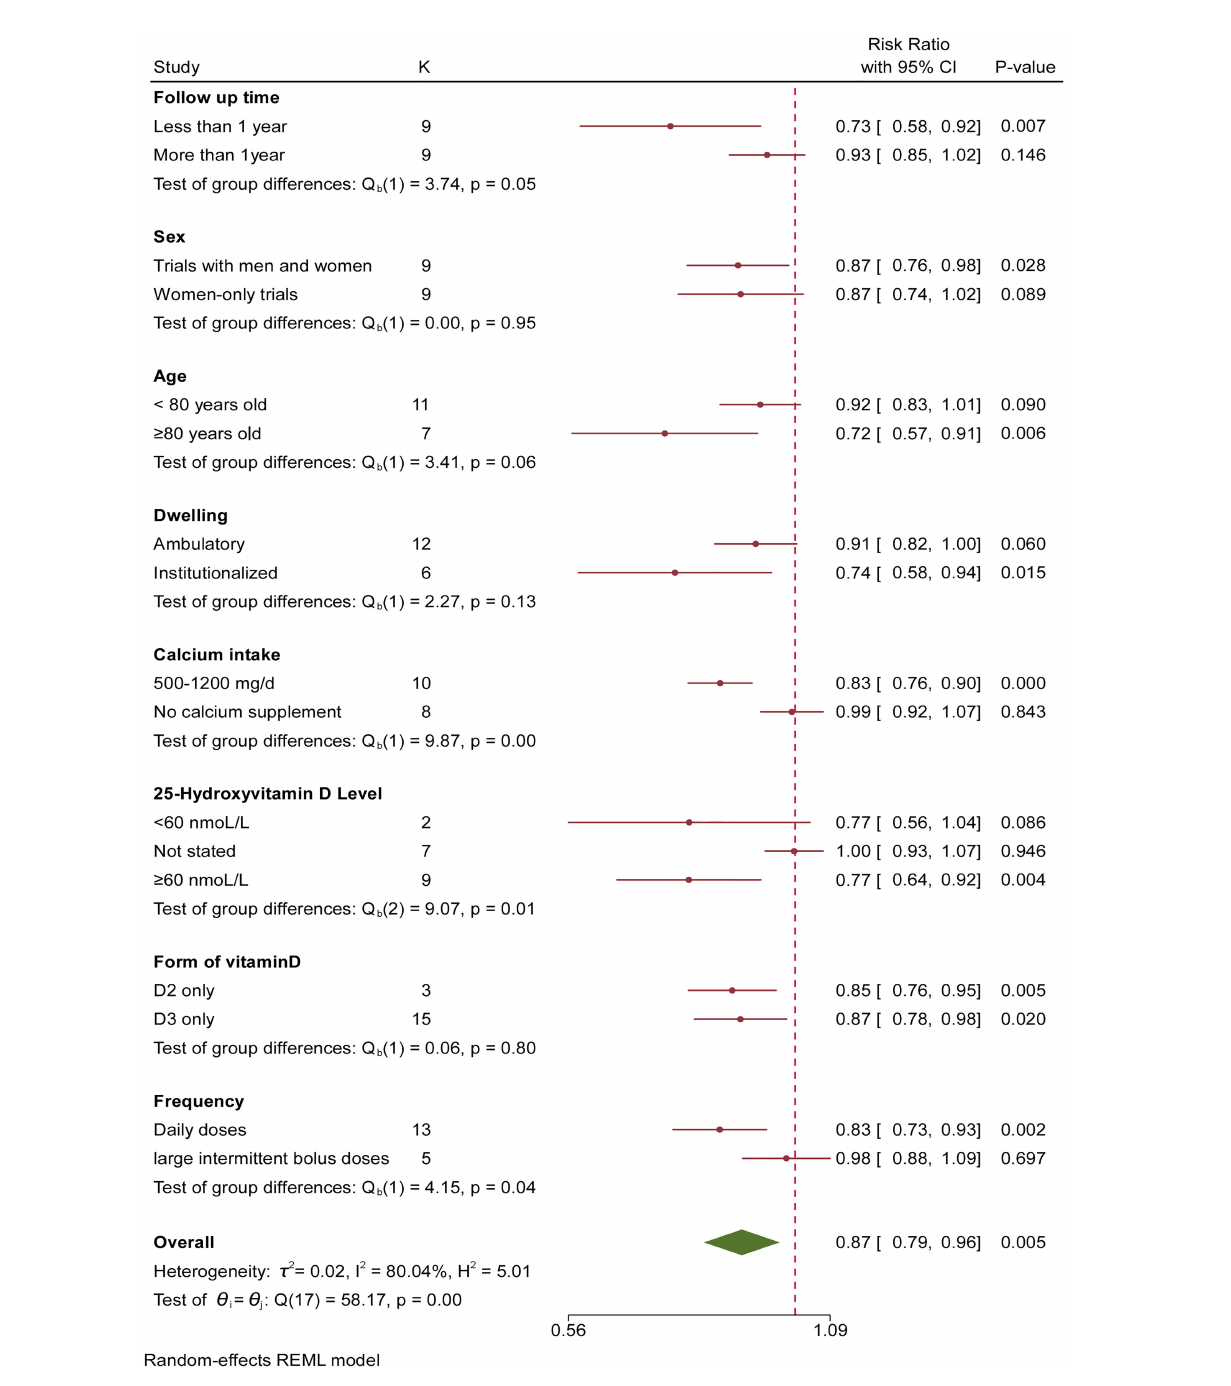
FIGURE 3 | Subgroup Analysis of Association Between Vitamin D Supplementation and Fall Incidence for Each Variable. Risk ratios and 95% CIs were calculated using a random-effects model to pool data. Boxes represent relative risks, and the size of the boxes is proportional to the size of the high dose supplemental vitamin D trials included in the primary analysis. Error bars represent 95% con fi dence